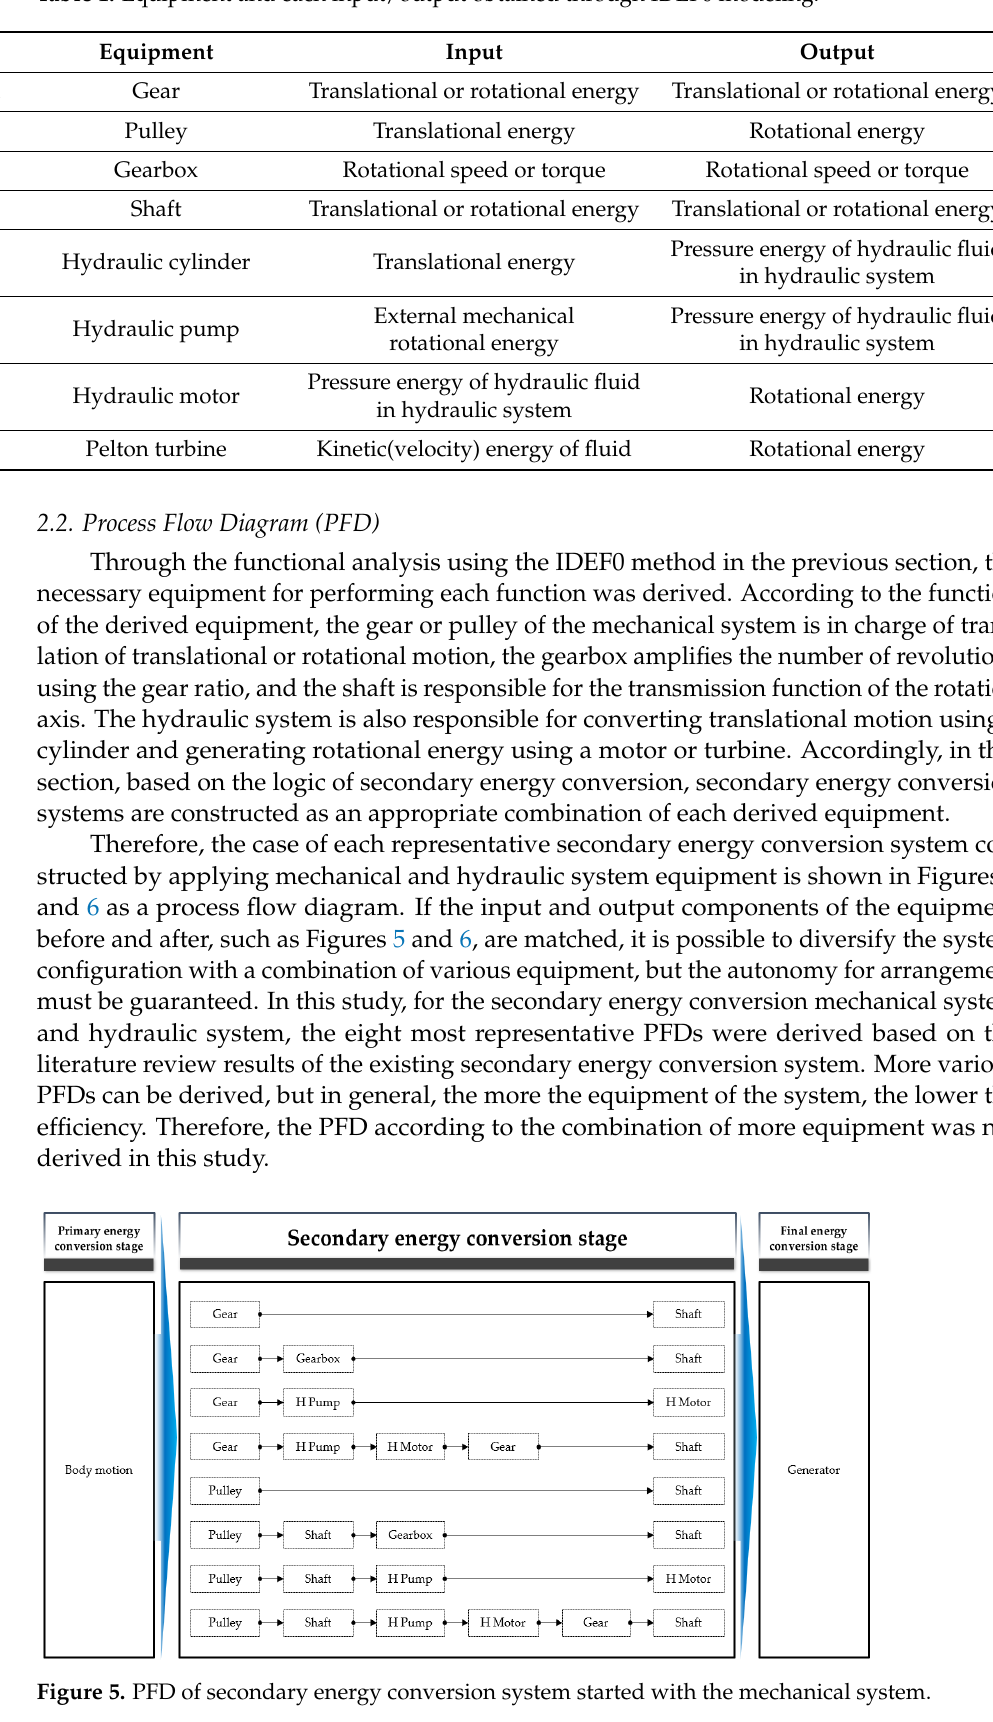
Figure 6. PFD of secondary energy conversion system started with the hydraulic system. 3. Development of Reliability Assessment Program In this chapter, according to the system configuration of the PFD derived in the pre- vious chapter, a program was developed to assess the reliability when each equipment of the secondary energy conversion mechanical system transmits energy. The RPM gener- ated by the primary energy conversion is the input to the secondary energy conversion formula, and the RPM by the secondary energy conversion is the output. To express this, a DB and a formula for reliability assessment of gears and pulleys, which are the equip- ment of the mechanical system, were constructed. Additionally, when evaluating the per- formance of secondary energy conversion including the hydraulic system, the efficiency at each stage was assumed to be 85% for the hydraulic pump [32] and 90% for the hydrau- lic motor [33]. 3.1. DB and Formula for Reliability Assessment of Gear The efficiency DB of the gear, which is the main mechanical equipment of the sec- ondary energy conversion system, was built, and the energy conversion formula for reli- ability assessment was built using this DB. In the gear system, power loss does not occur